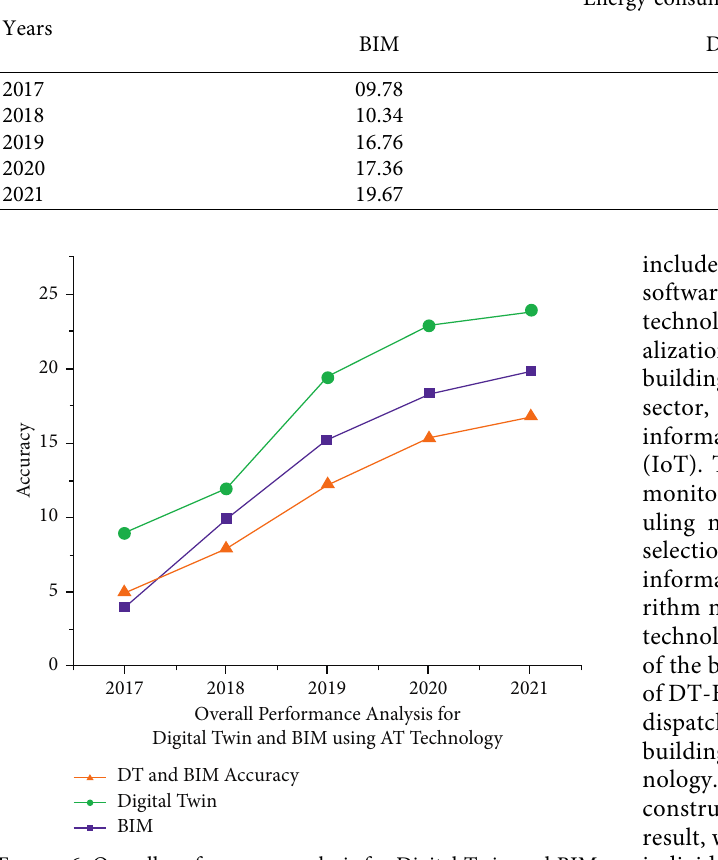
Figure 6: Overall performance analysis for Digital Twin and BIM using AI technology. Table 5: Overall performance result analysis for Digital Twin and BIM using AI